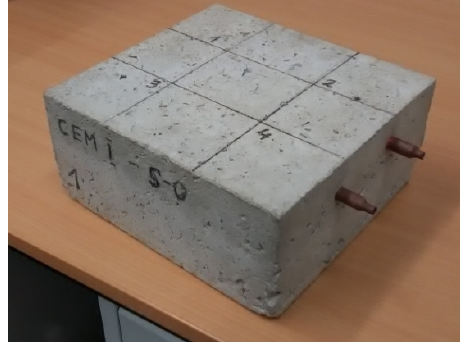
Figure 4. The test specimen.